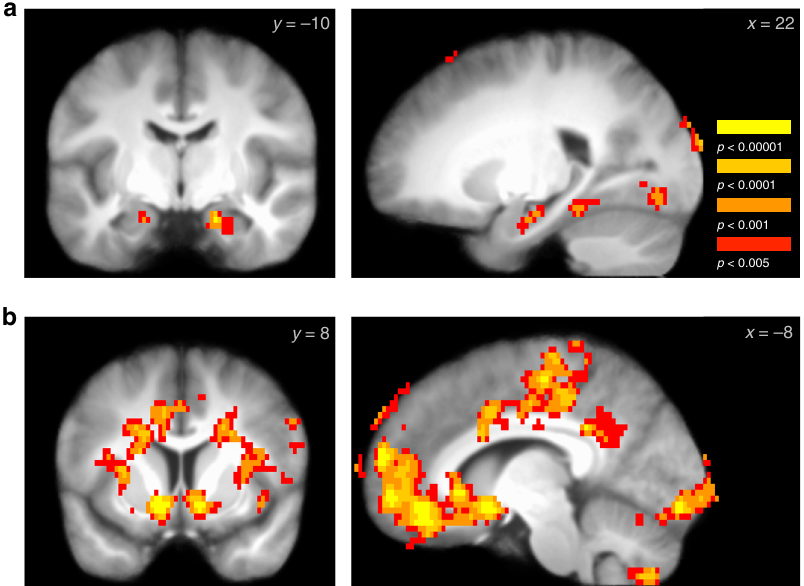
Fig. 2 Learning-related univariate fMRI responses. a Across repetition of mazes during the learning phase, activity in the hippocampus signi fi cantly decreased, supporting a role for the hippocampus in maze encoding (right and left hippocampus, p < 0.05 SVC; image threshold p < 0.005 unc.). b At feedback, beginning >40 s after the start of a maze, activation in the ventral striatum and OFC - ventromedial PFC, among other regions, was signi fi cantly activated by the receipt of a reward versus loss. (Images p < 0.05 whole-brain FWE-corrected; full maps available at: https://neurovault.org/images/ 100616/ and https://neurovault.org/images/100619/) ~40 s after the state 1 choice for each maze, was correlated with 0.028 SVC; − 30 − 18 − 15; this effect was also part of a larger BOLD activity in a cluster including the ventral striatum and signi fi cant cluster in the whole-brain analysis), in line with OFC-VMPFC (Fig. 2b; Supplementary Fig. 2). We also found predictions from fMRI research on responses to relatively delayed reward-related activation in the left hippocampus (z = 3.84; p = feedback (~7 s) 33 . Note that these results revealed some clusters of NATURE COMMUNICATIONS| (2019) 10:2554